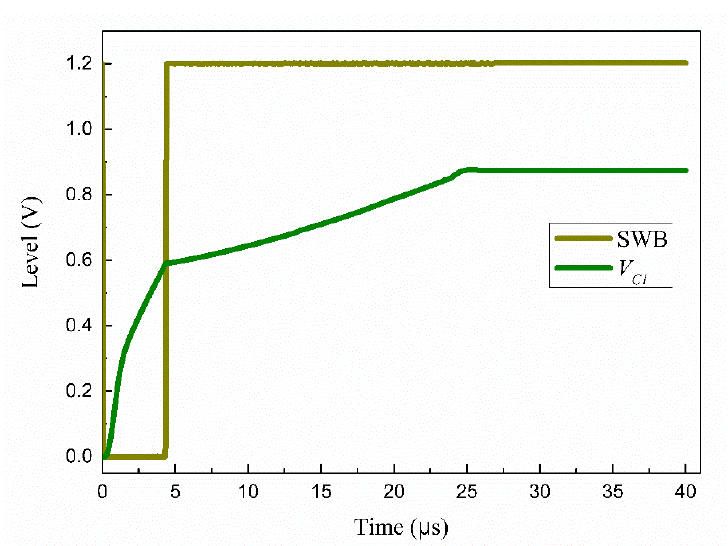
Figure 7. The SWB and V C1 levels with time.